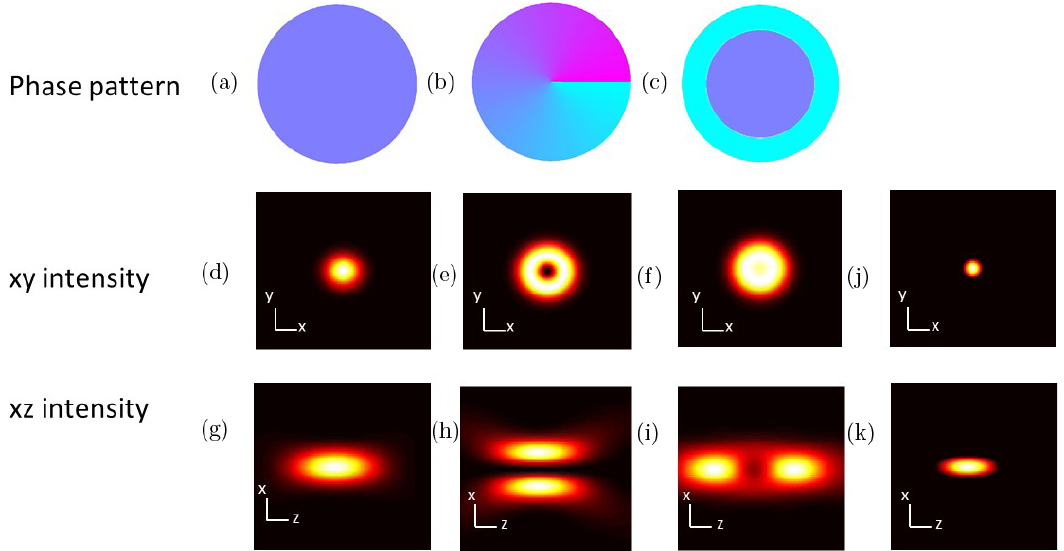
Fig. 1. Phase patterns and the corresponding normalized intensity distribution.